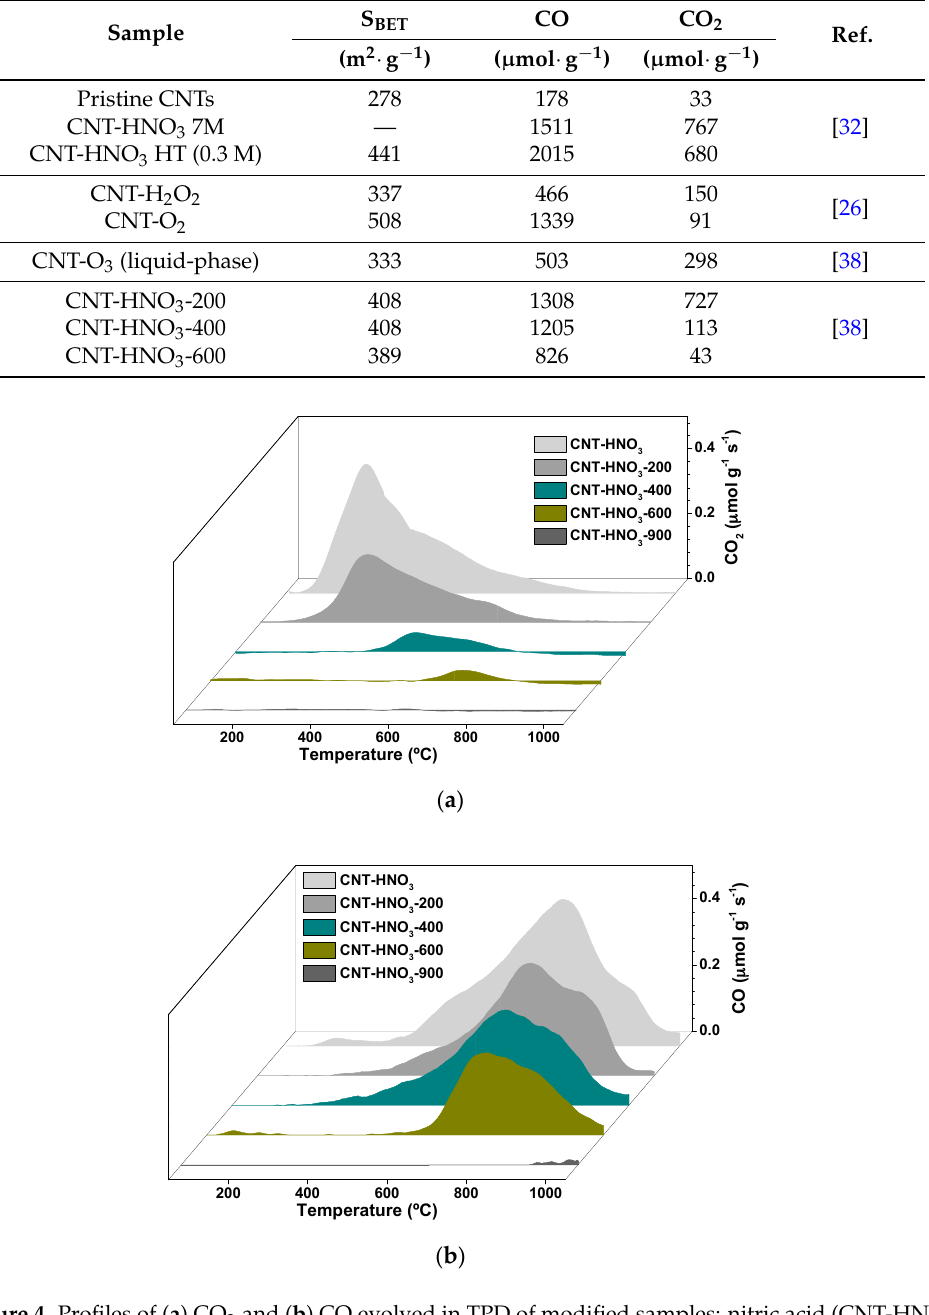
Figure 4. Profiles of ( a ) CO 2 and ( b ) CO evolved in TPD of modified samples: nitric acid (CNT-HNO 3 ) and thermally treated samples (CNT-HNO 3 -200, CNT-HNO 3 -400, CNT-HNO 3 -600, CNT-HNO 3 -900) (adapted from [26,38]).